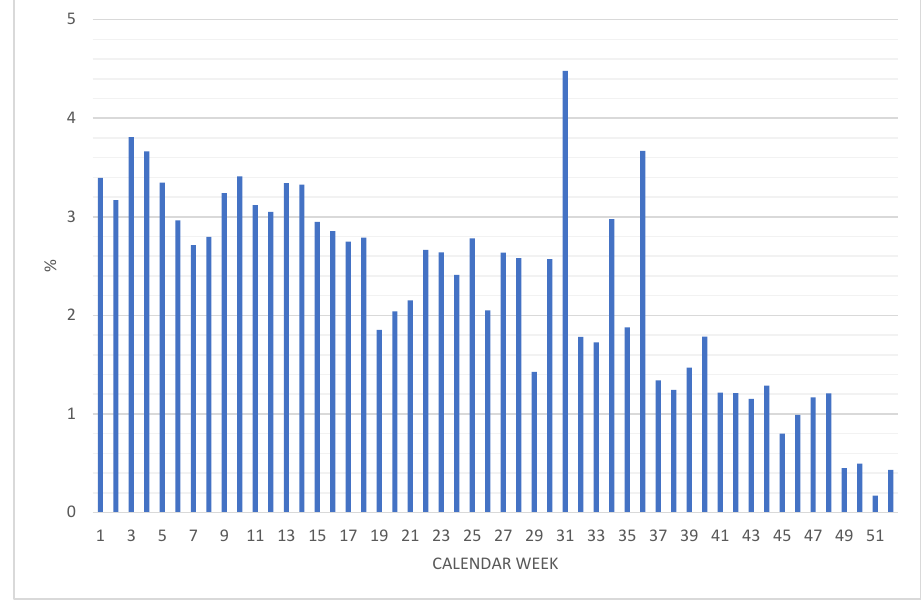
Figure 2. Proportion of cases (%) involving inpatient treatment among the reported cases in the respective calendar weeks of 2021.